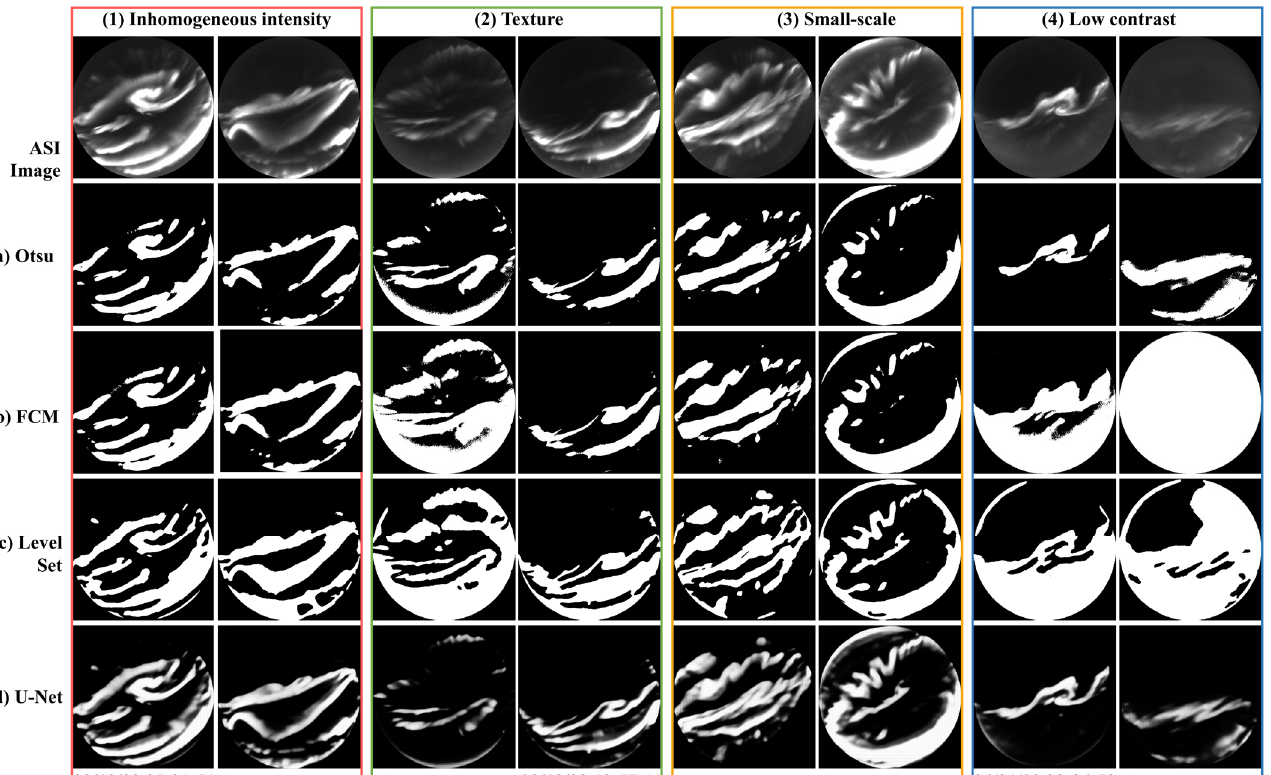
Figure 6. The aurora segmentation results by using different segmentation methods.